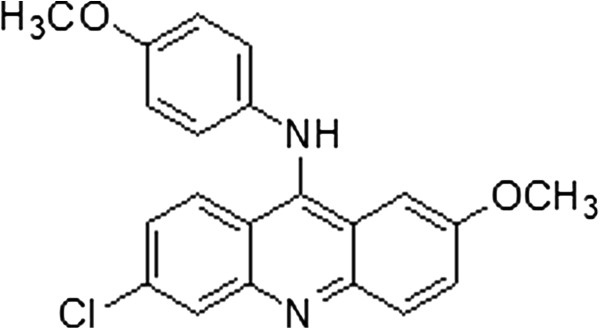
Virtual hit inhibiting Src at a moderate rate of 4.85% at 20 μM.